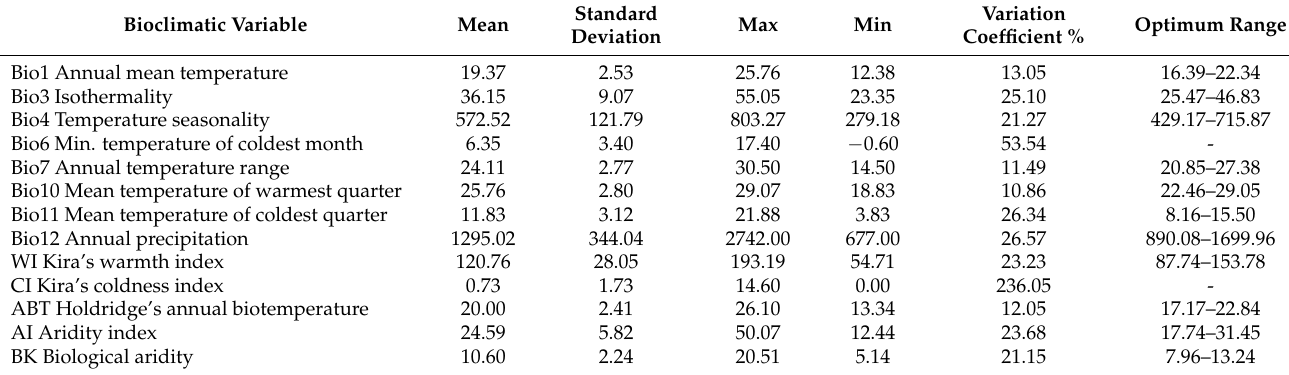
Table 3. Descriptive statistics of the main bioclimatic parameters in the cultivated areas of J. mimosifolia in China. Bioclimatic